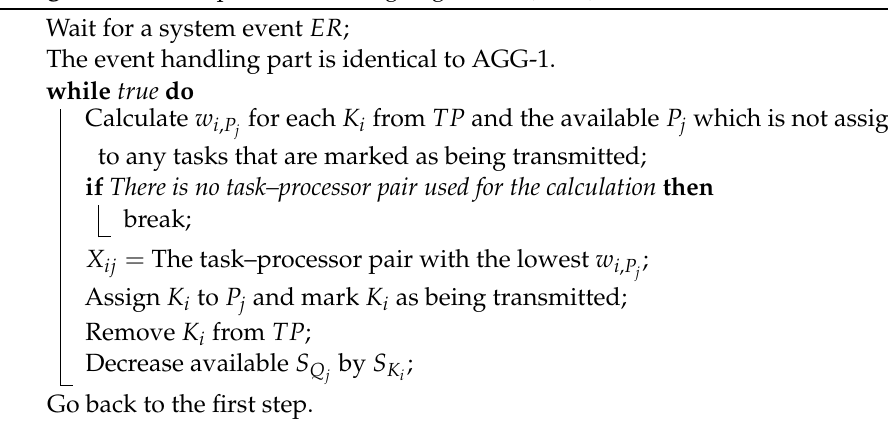
Algorithm 2: Adaptive Offloading Algorithm